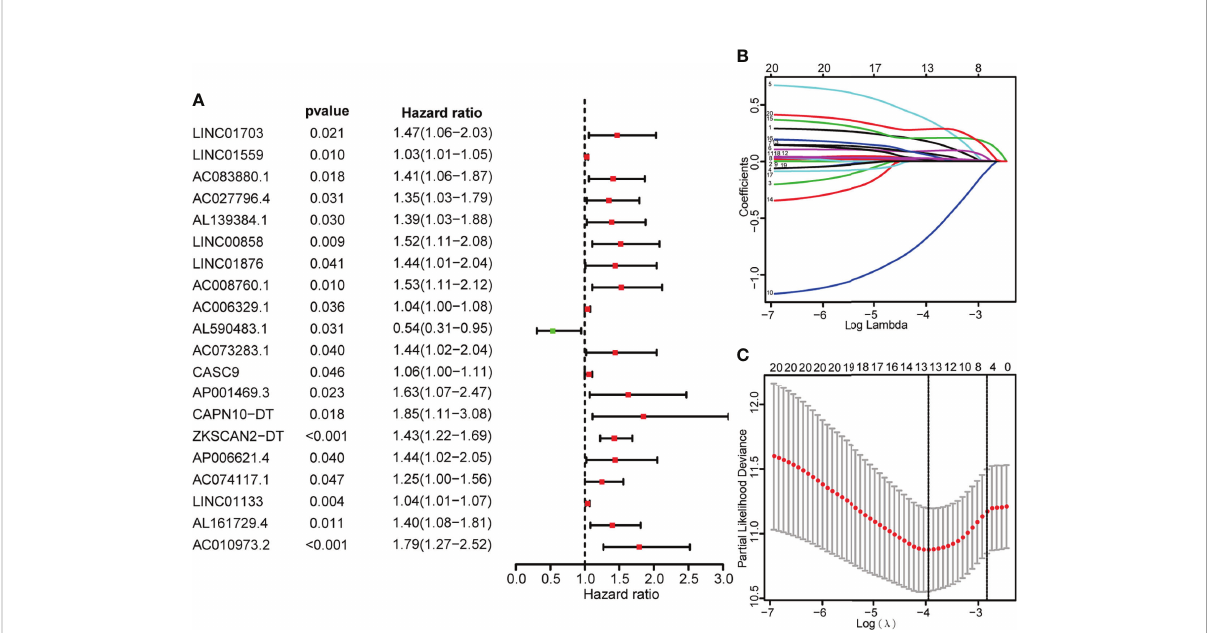
FIGURE 2 Identify metabolic-related lncRNAs having prognostic signi fi cance for colon cancer. (A) COX forest plot demonstrated that 20 metabolic-related lncRNAs were substantially correlated with the OS of colon cancer (P< 0.05). (B, C) The adjustment parameters of the LASSO regression model, LASSO coef fi cient spectrum of prognostic-related lncRNAs, 10-fold cross-validation to fi ltrate candidate necroptosisrelated lncRNAs in LASSO regression